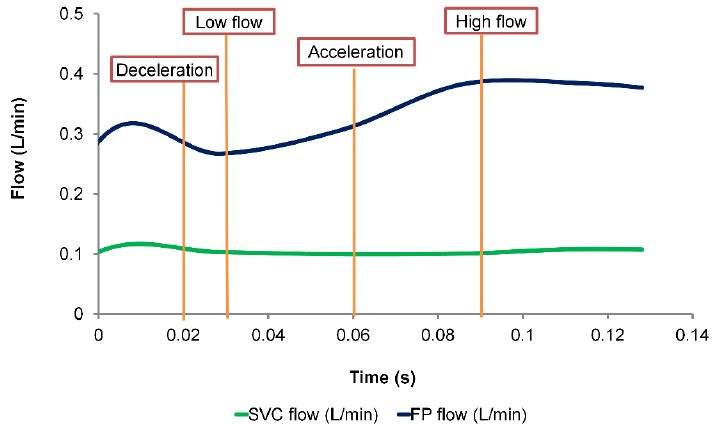
Figure 4. Low waveform of the mesh sensitivity study. Maximum mesh displacement was extracted at four phases (deceleration, low flow, acceleration and high flow) and compared between the different mesh sizes. FP: Fontan pathway, SVC: superior vena cava.